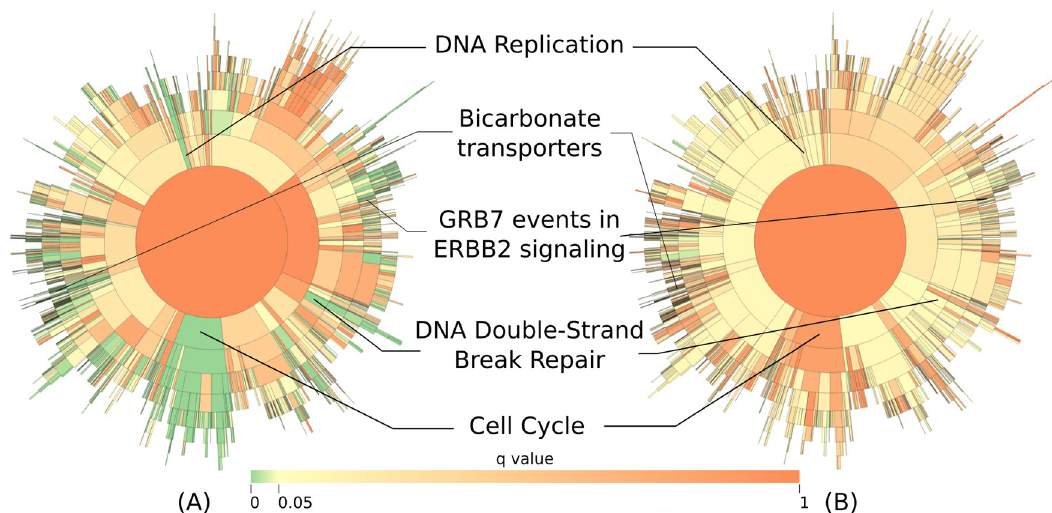
Fig 4. Sunburst diagrams offer an exploratory visualization of the influence of the pathways in the Reactome hierarchy on the survival of patients. We use an interactive sunburst chart to visualize and explore the result. This allows us to navigate the pathway hierarchy and see the relationships in a more natural way than e.g. in a static table. The sunburst (A) without and (B) with the pathway “Diseases of mitotic cell cycle” regressed out. Interactive versions of the same figures are available from https://